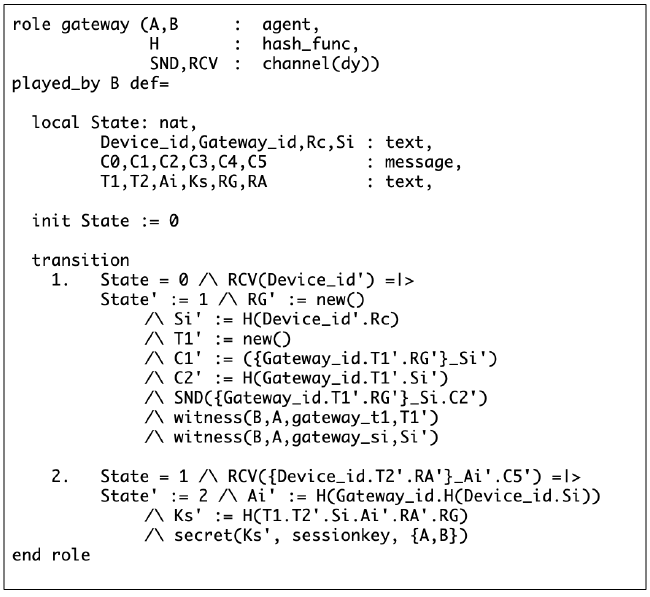
Figure 10. Specification of the HGW role for high security